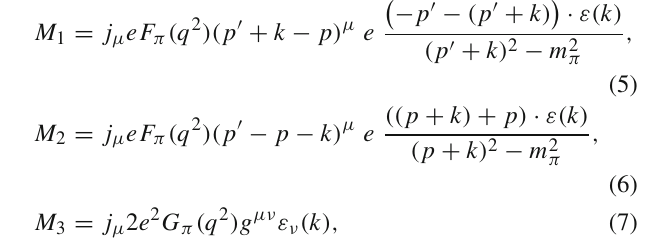
Fig. 6 ISR Feynman diagrams of process (10) in which the choice of four momentum transfer in the charged pion form factor, represented by the red blob , may be ambiguous